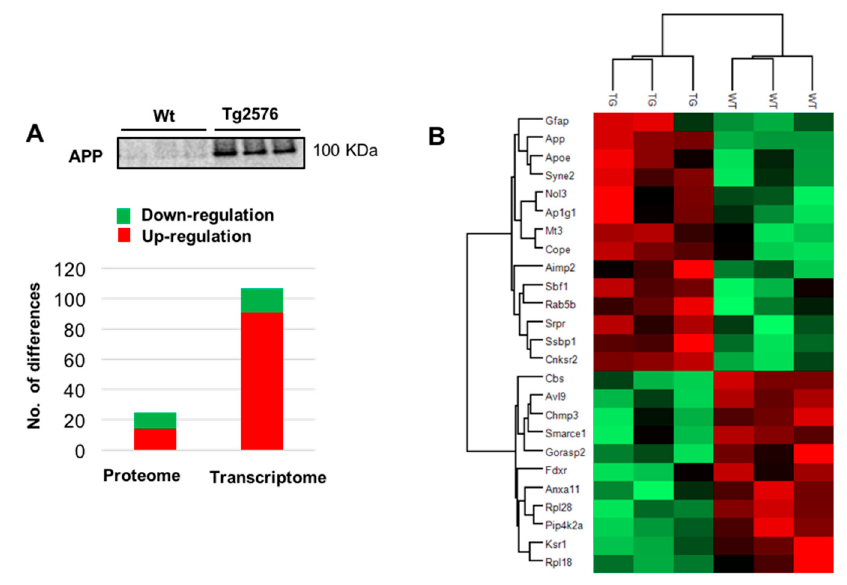
Figure 2. Figure 2. Cont. Figure 2. Cont.